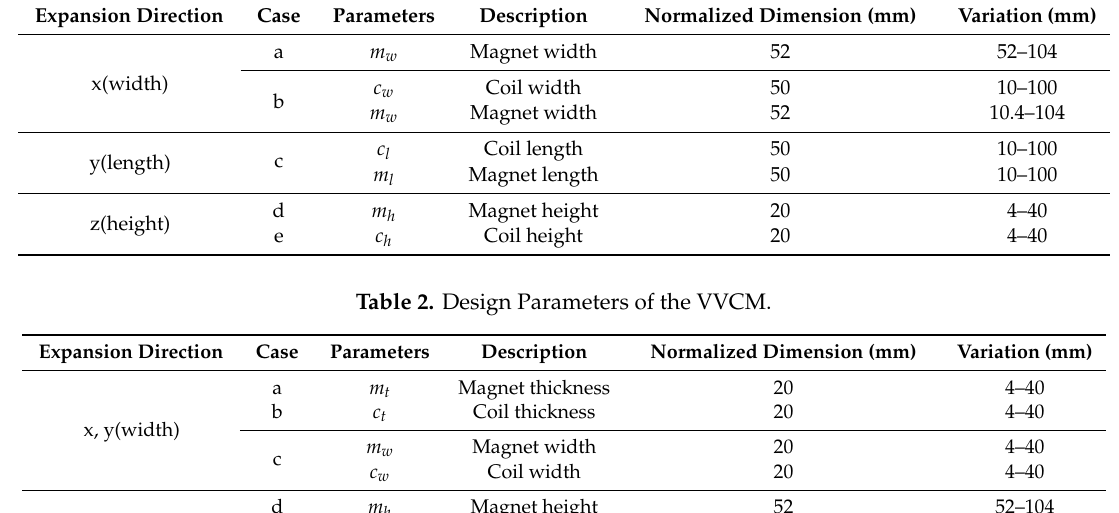
Figure 3. Variations of the vertical force voice coil motor (VVCM)’s structure according to changes in the design parameters: ( a ) case (a), change of magnet thickness; ( b ) case (b), change of coil thickness; ( c ) case (c), change of VCM width; ( d ) case (d) change of magnet height; ( e ) case (e) change of VCM height. Table 1. Design Parameters of the HVCM.